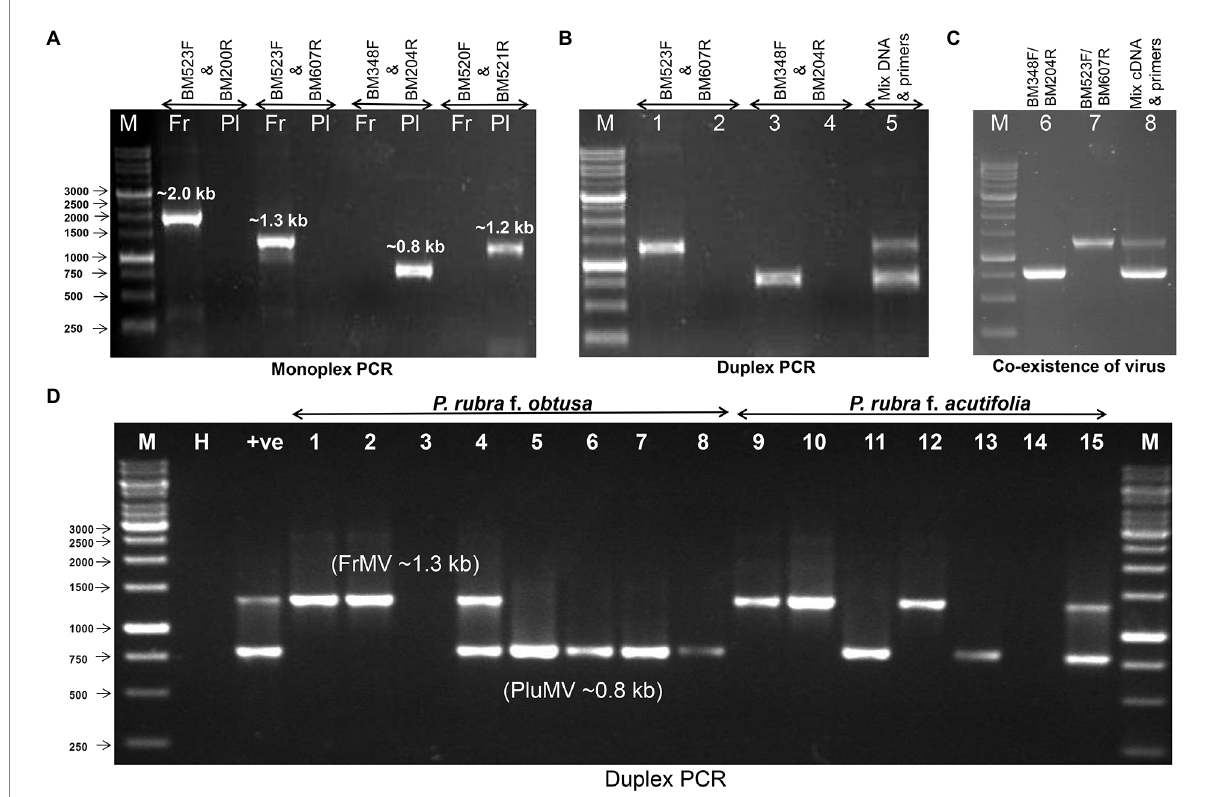
FIGURE 6 Detection of frangipani mosaic virus (FrMV-Ind-1) and plumeria mosaic virus (PluMV-Plu-Ind-1) by RT-PCR. (A) Optimization of specificity of the primers using the cloned DNA of FrMV-Ind-1 and PluMV-Plu-Ind-1. (B) Duplex PCR using the cloned DNA of FrMV-Ind-1 and PluMV-Plu-Ind-1 with the specific primers BM523F/BM607R and BM348F/BM204R, respectively. M: Marker, Lane 1: FrMV clone tested by FrMV specific primers, Lane 2: FrMV clone tested by PluMV specific primers, Lane 3: PluMV clone tested by PluMV specific primers, Lane 4: PluMV clone tested with FrMV specific primers, Lane 5: Duplex PCR (mixture of both the clone tested with mixture of primers). (C) Confirmation of co-infection of both the virus (FrMV and PluMV) in original frangipani tree ( Plumeria rubra f. acutifolia ) from where both the viruses were isolated. M: Marker, Lane 1: RT-PCR by FrMV specific primers, Lane 2: RT-PCR by PluMV specific primers, Lane 3: Duplex RT-PCR with the mixture of both the primers. (D) Duplex RT-PCR confirmation of single and mixed infection of PluMV and FrMV in the leaf samples collected from different trees at IARI campus. M: Marker, H: Healthy, +ve: Duplex RT-PCR from RNA extracted from the original frangipani tree, Lane 1–15: leaf samples. Fr: FrMV; Pl: